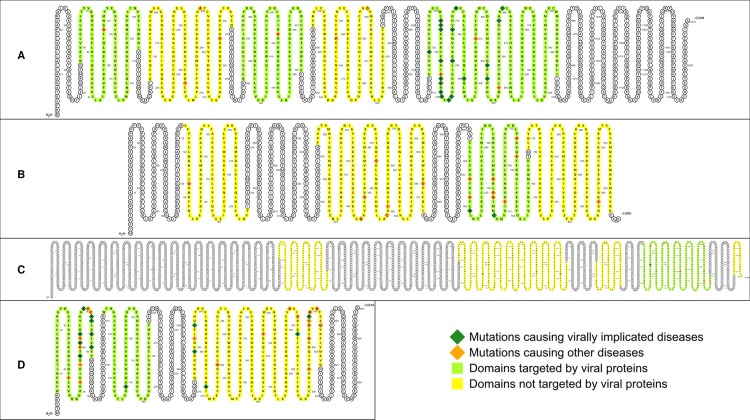
Exclusive localization or enrichment of VID mutations in virus-targeted domains.(A) Exclusive localization of mutations causing lung cancer, an EBV-implicated disease, in EBV-targeted tyrosine kinase domain of EGFR protein. (B) Exclusive localization of mutations causing vulvar cancer and lung cancer, both HPV-implicated diseases, in HPV-targeted B domain of RB protein. (C) Exclusive localization of mutations causing cervical cancer, an HIV-implicated disease, in HIV-targeted PI3-kinase domain of MTOR protein, while mutations causing other diseases such as focal cortical dysplasia and Smith-Kingsmore syndrome are evenly distributed among all domains of MTOR. (D) Moderate enrichment of oncomutations in KSHV-targeted SH2 domain of PTPN11 protein, compared to mutations causing Noonan syndrome. Most of the oncomutations cause juvenile myelomonocytic leukemia, a disease although not caused by KSHV, is mimicked clinically and morphologically by other human herpesvirus infections, including EBV, CMV and HHV-6. VID mutations are shown as dark green diamonds. Non-VID mutations are shown as orange diamonds. Amino acid residues in virus-targeted domains are shown as light green squares. Residues in domains not targeted by virus are shown as yellow squares.